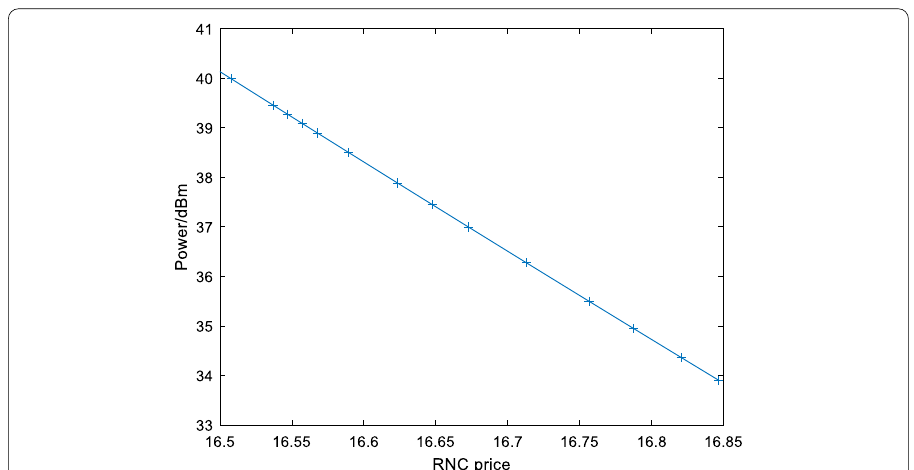
Fig. 3 Power varies with RNC’s price. This figure shows the relationship between RNC’s price and base station power